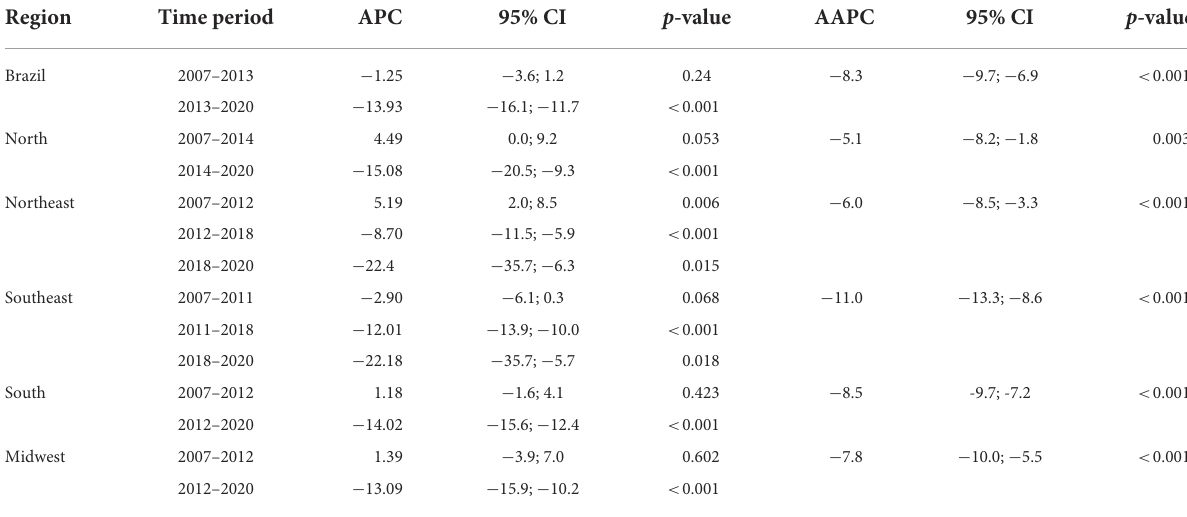
TABLE 3 Temporal trend analysis of annual aged-adjusted HIV/AIDS population-level incidence rates in Brazilian WSW, 2007–2020. Region Time period APC 95% CI p -value AAPC 95% CI